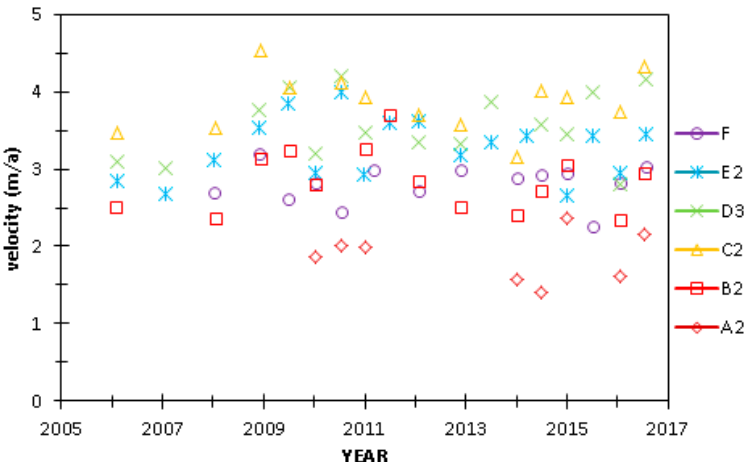
Figure 3. The measured velocities (m/a) for every observation span at the 6 stakes along the central flow line, 2005–2016. The different colors denote different stakes. Each dot corresponds to the mean velocity between two measurements.